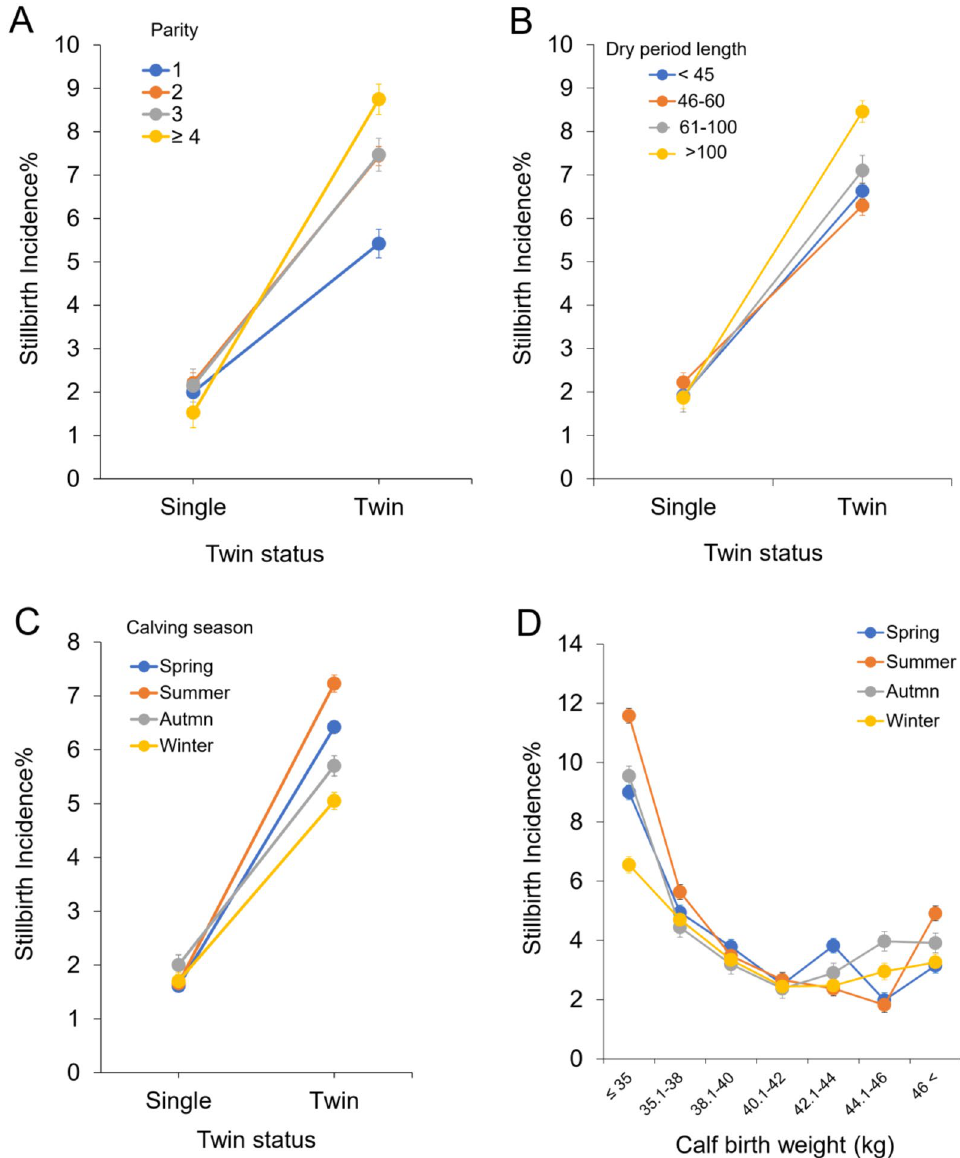
Figure 3. Interaction effects of parity × twin status ( A ), dry period length × twin status ( B ) and calving season × twin status ( C ) and calving season × calf birth weight ( D ) were significantly associated with the incidence of